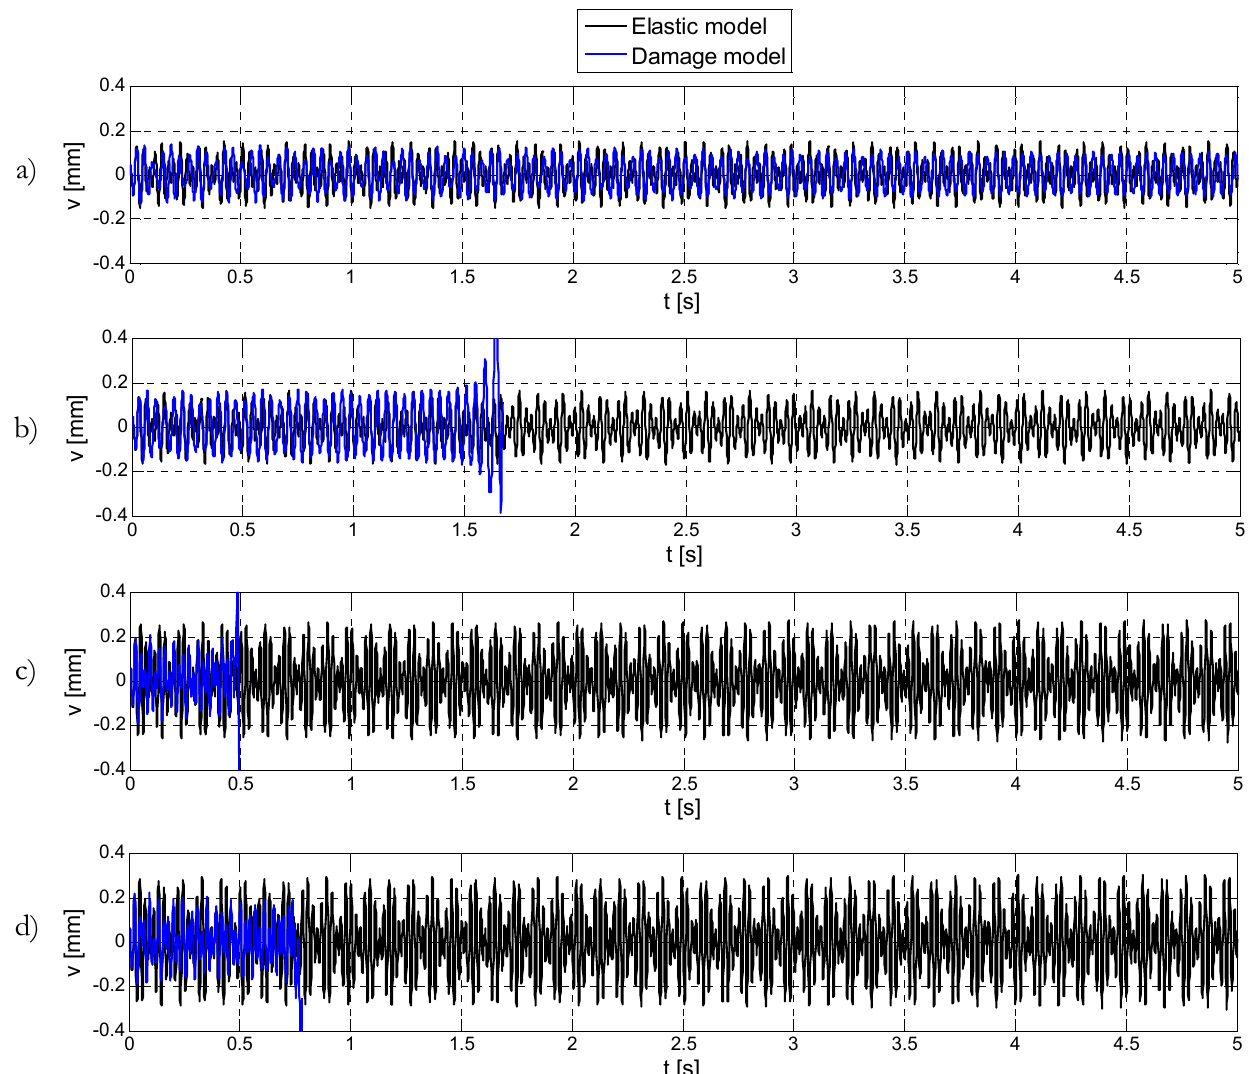
Figure 8: Time history of the